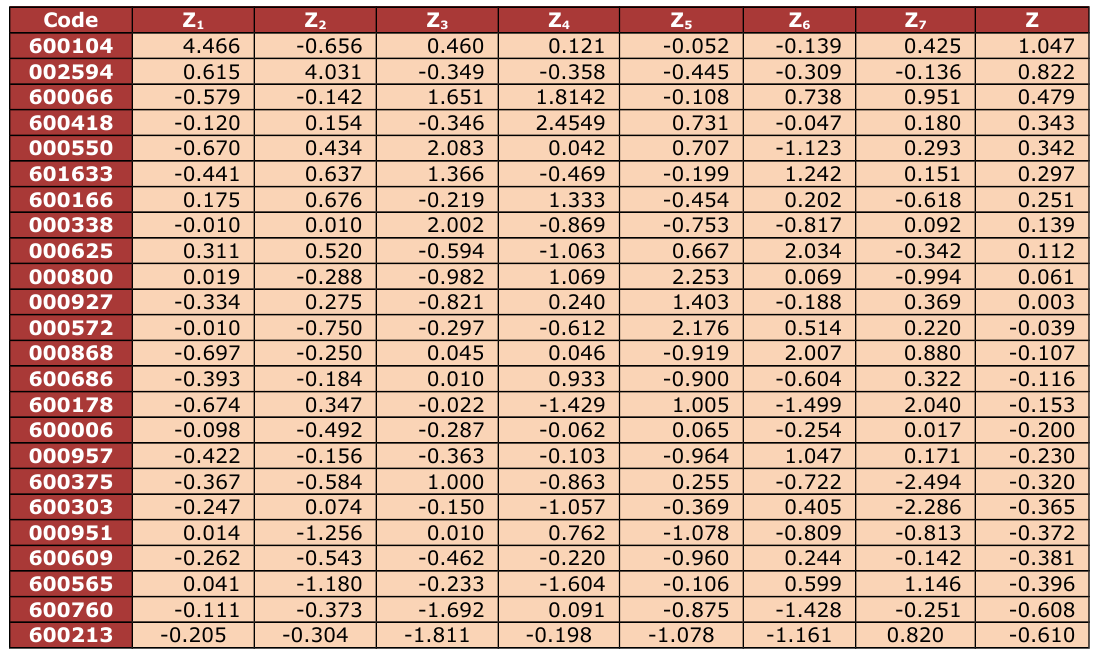
Table 5. Green competitiveness score for China automotive